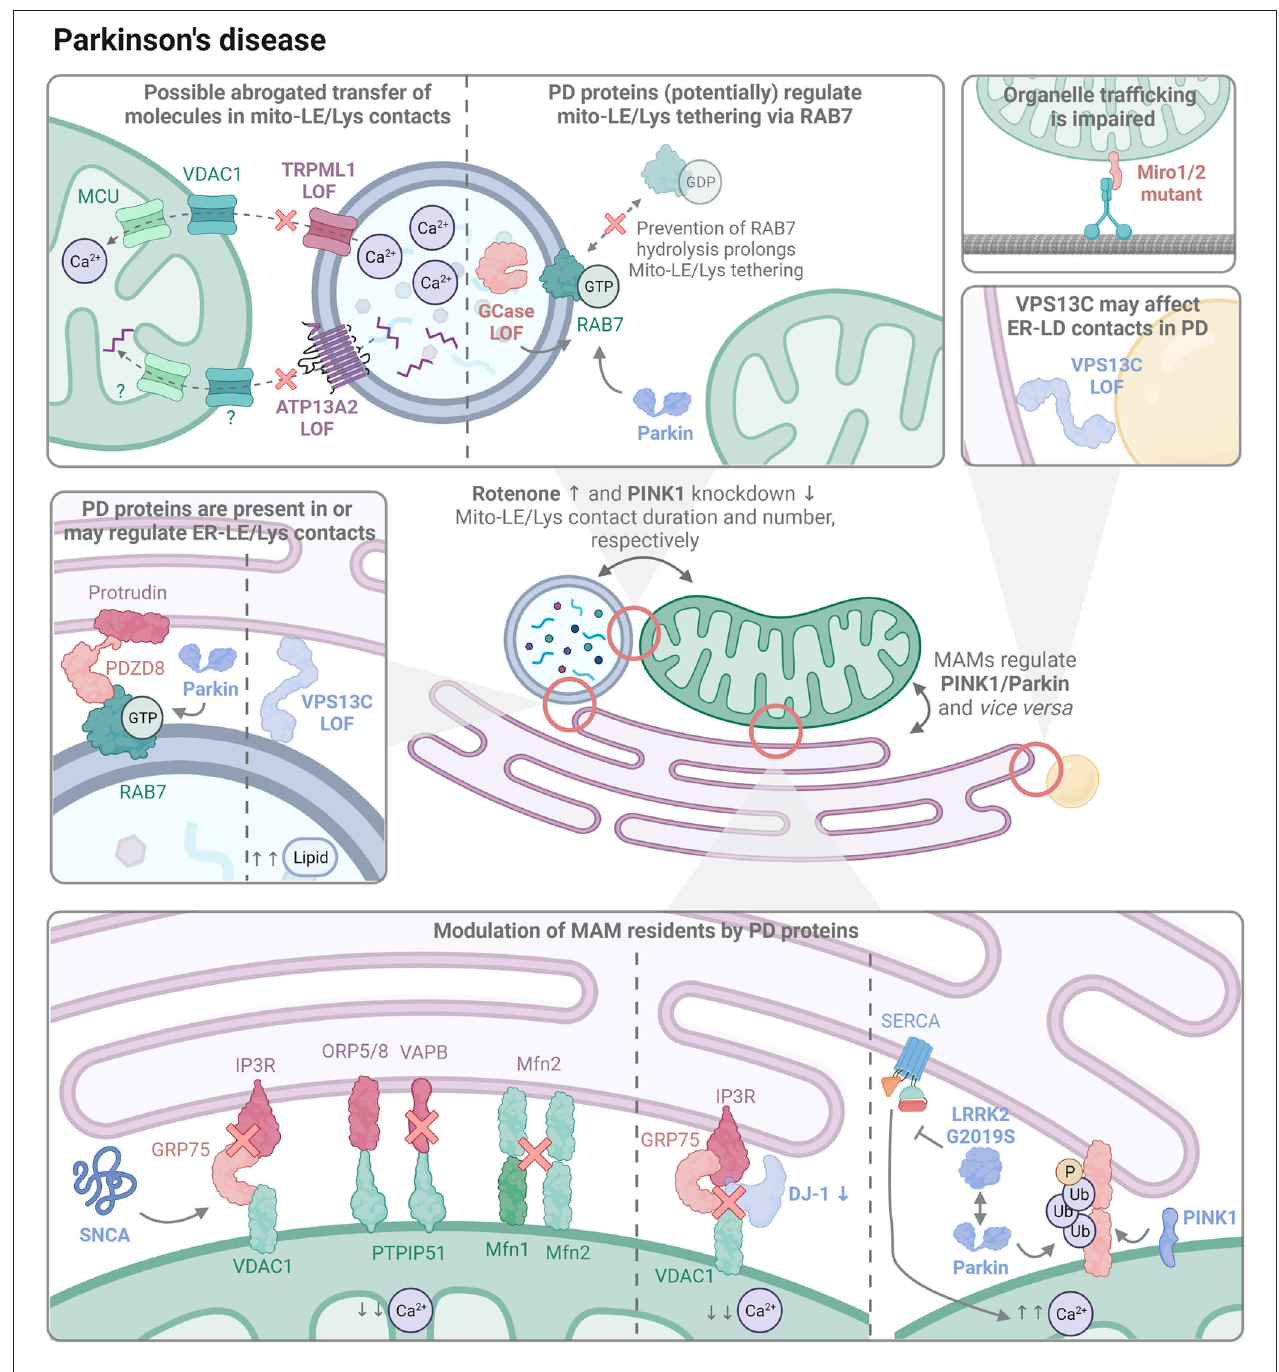
FIGURE 2 | The organelle interactome in PD. PD-linked proteins (indicated in bold) are involved in the regulation of multiple contact sites, ranging from mitochondrial-late endo/lysosomal (mito-LE/Lys), endoplasmic reticulum-late endo/lysosomal (ER-LE/Lys), endoplasmic reticulum-lipid droplet (ER-LD), and mitochondrial-endoplasmic reticulum (MAMs) contacts. New hypothetical mediators and mechanisms are illustrated as well as established ones. LOF,